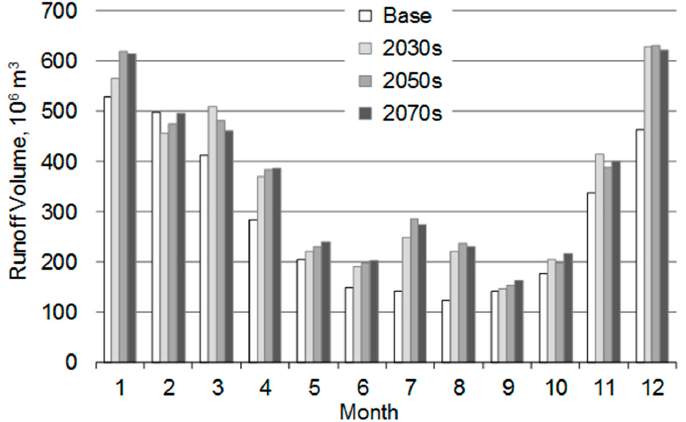
Figure 5. Monthly runoff volume into Norris Reservoir for Base, 2020s, 2050s, and 2070s.